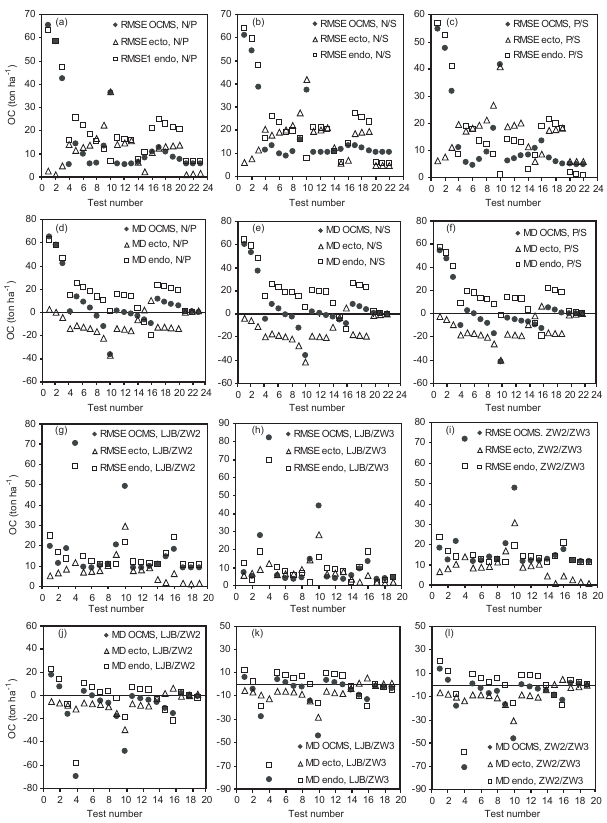
Fig. 4. Quality indices for calibration results. (a) RMSE of aver- age OC mass in N/P pedons in Belgium; (b) RMSE of average OC mass in N/S pedons in Belgium; (c) RMSE of average OC mass in P/S pedons in Belgium; (d) MD of average OC mass in N/P pedons in Belgium; (e) MD of average OC mass in N/S pedons in Belgium; (f) MD of average OC mass in P/S pedons in Belgium; (g) RMSE of average OC mass in LJB/ZW2 pedons in China; (h) RMSE of average OC mass in LJB/ZW3 pedons in China; (i) RMSE of av- erage OC mass in ZW2/ZW3 pedons in China; (j) MD of average OC mass in LJB/ZW2 pedons in China; (k) MD of average OC mass in LJB/ZW3 pedons in China; (l) MD of average OC mass in ZW2/ZW3 pedons in China.